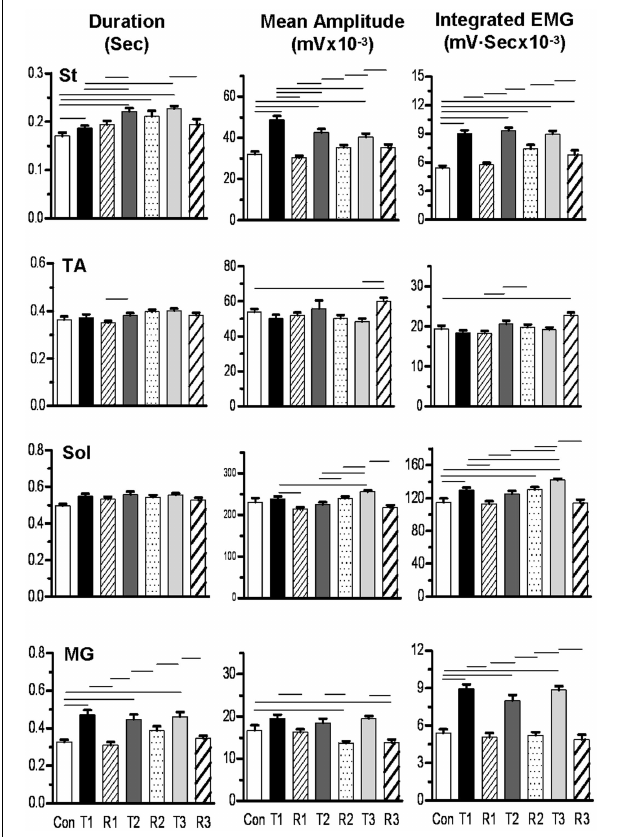
FIGURE 8 | Bar graphs showing the mean (SEM) burst duration, amplitude, and integrated EMG for the semitendinosus (St), tibialis anterior (TA), soleus (Sol), and medial gastrocnemius (MG) muscles for three trip-release sequences for a representative cat. Con, control sequence, 10 steps;T1, first trip sequence, 20 steps; R1, first release sequence, 20 steps;T2, second trip sequence, 20 steps; R2, second release sequence, 20 steps;T3, third trip sequence, 20 steps; R3, third release sequence, 20 steps.The horizontal lines above the bars denote significant differences between conditions at P < 0.05. Note that the St showed the highest activation levels compare to control during the trip steps and that the MG showed a qualitatively similar pattern as the